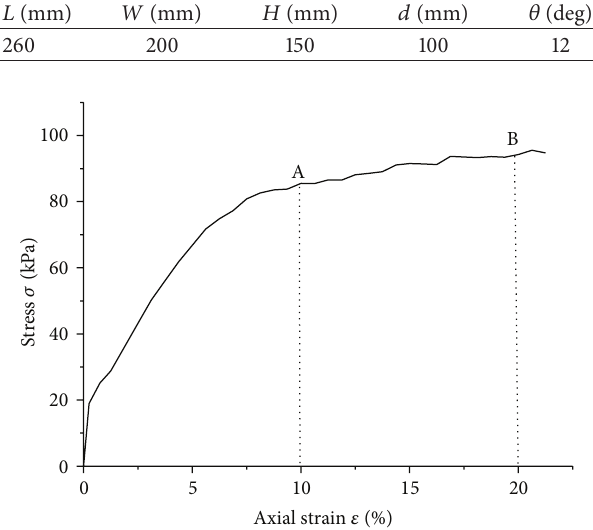
Table 2: Dimensions of the three-dimensional soil-cutting model.